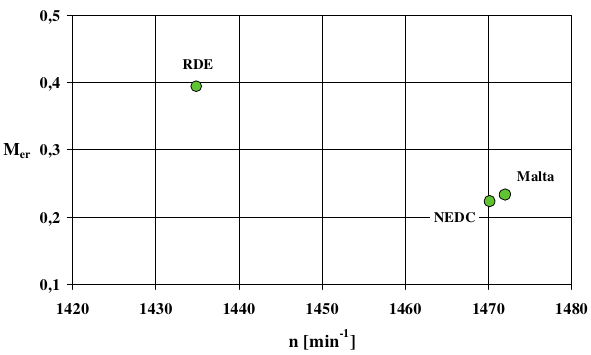
Fig. 16. A set of average engine speed points and an average relative torque value in coordinates: rotational speed–relative torque in NEDC, Malta and RDE tests Fig. 19. Histogram of relative torque in NEDC, Malta and RDE